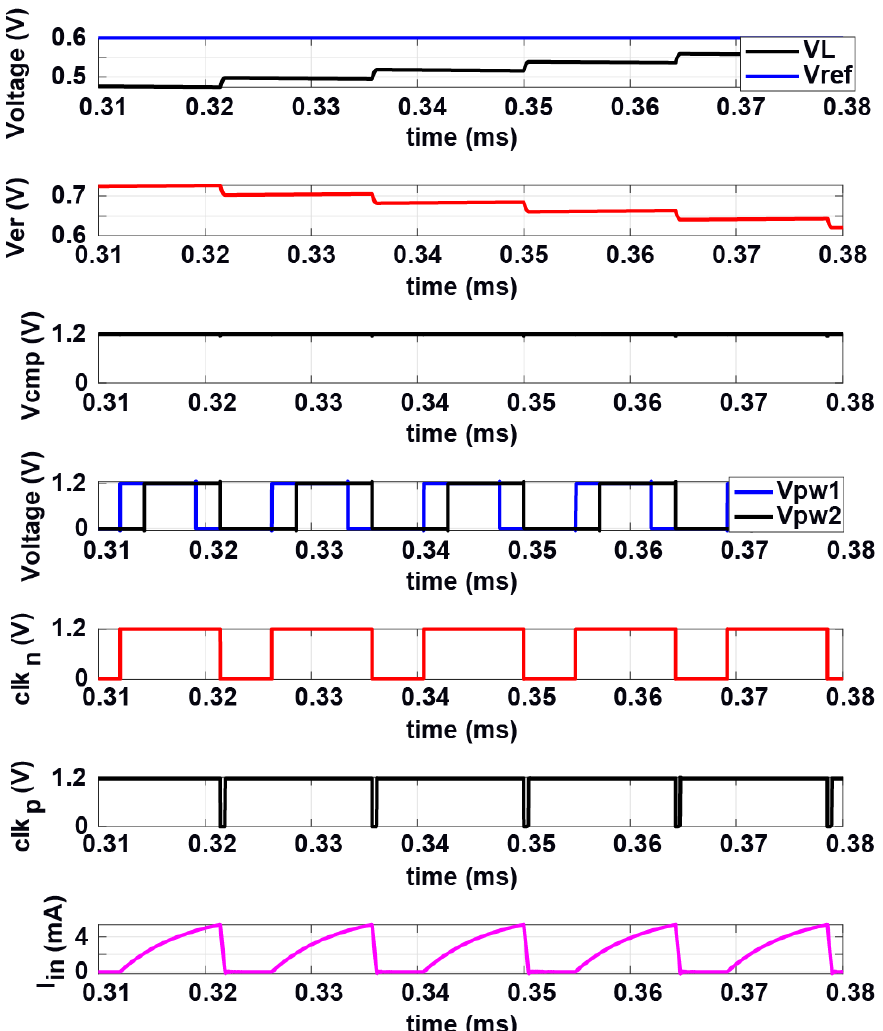
Figure 6. Transient response of the SI boost regulator with PWM and PSM feedback loops when V L < V ref at V L = 0.6 V, I L = 10 µ